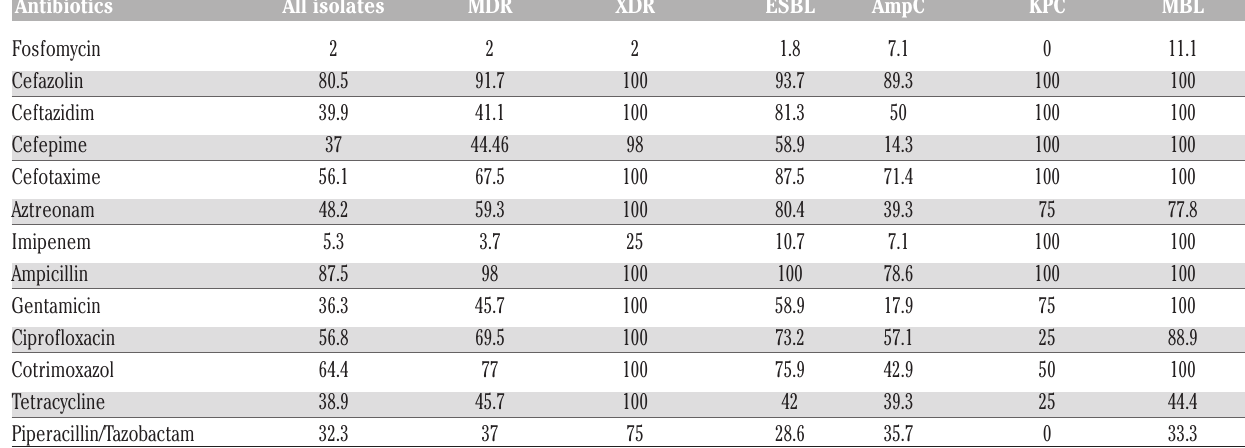
Table 2. In vitro resistance rates of multiple drug resistance (MDR), extensively drug resistance (XDR), extended spectrum beta-lacta- mase (ESBLs), class C cephalosporinases (AmpC), mannan-binding lectin (MBL) and Klebsiella pneumoniae Carbapenemase (KPC) producing Enterobacteriaceae i solates to different